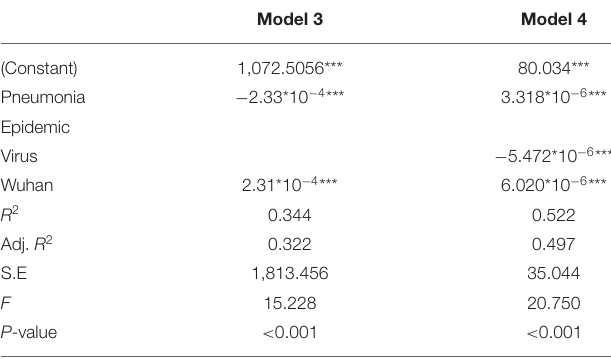
TABLE 2 | Forecast results of model 1 and model 2.